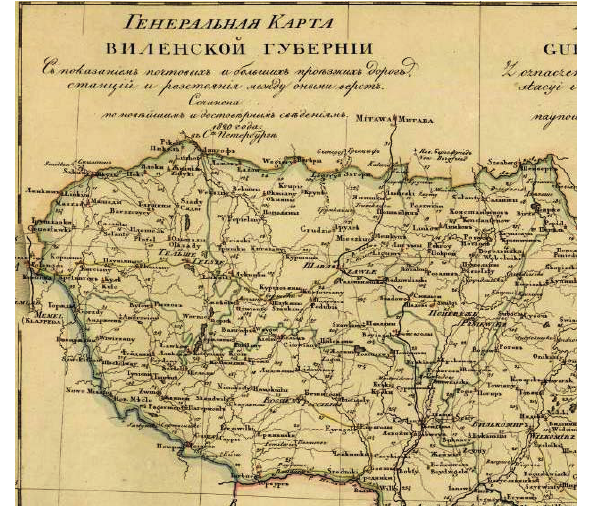
Fig. 15. Vilnius Province map scale 1: 1 092 000 fragment ed